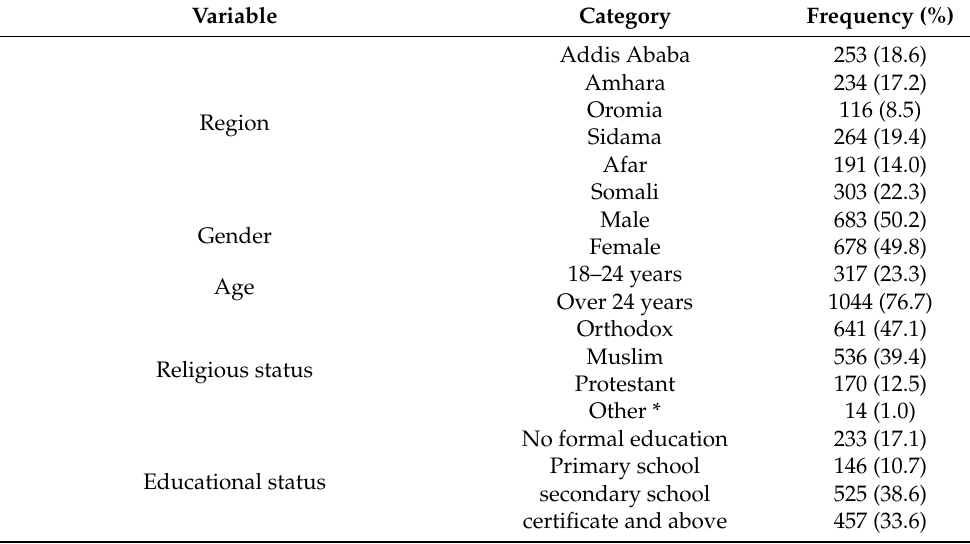
Table 2. Socio-demographic characteristics of COVID-19 vaccine hesitancy survey, Ethiopia, 2022.